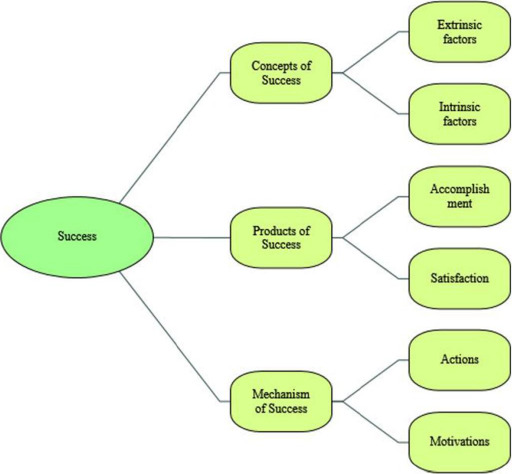
Thematic Analysis